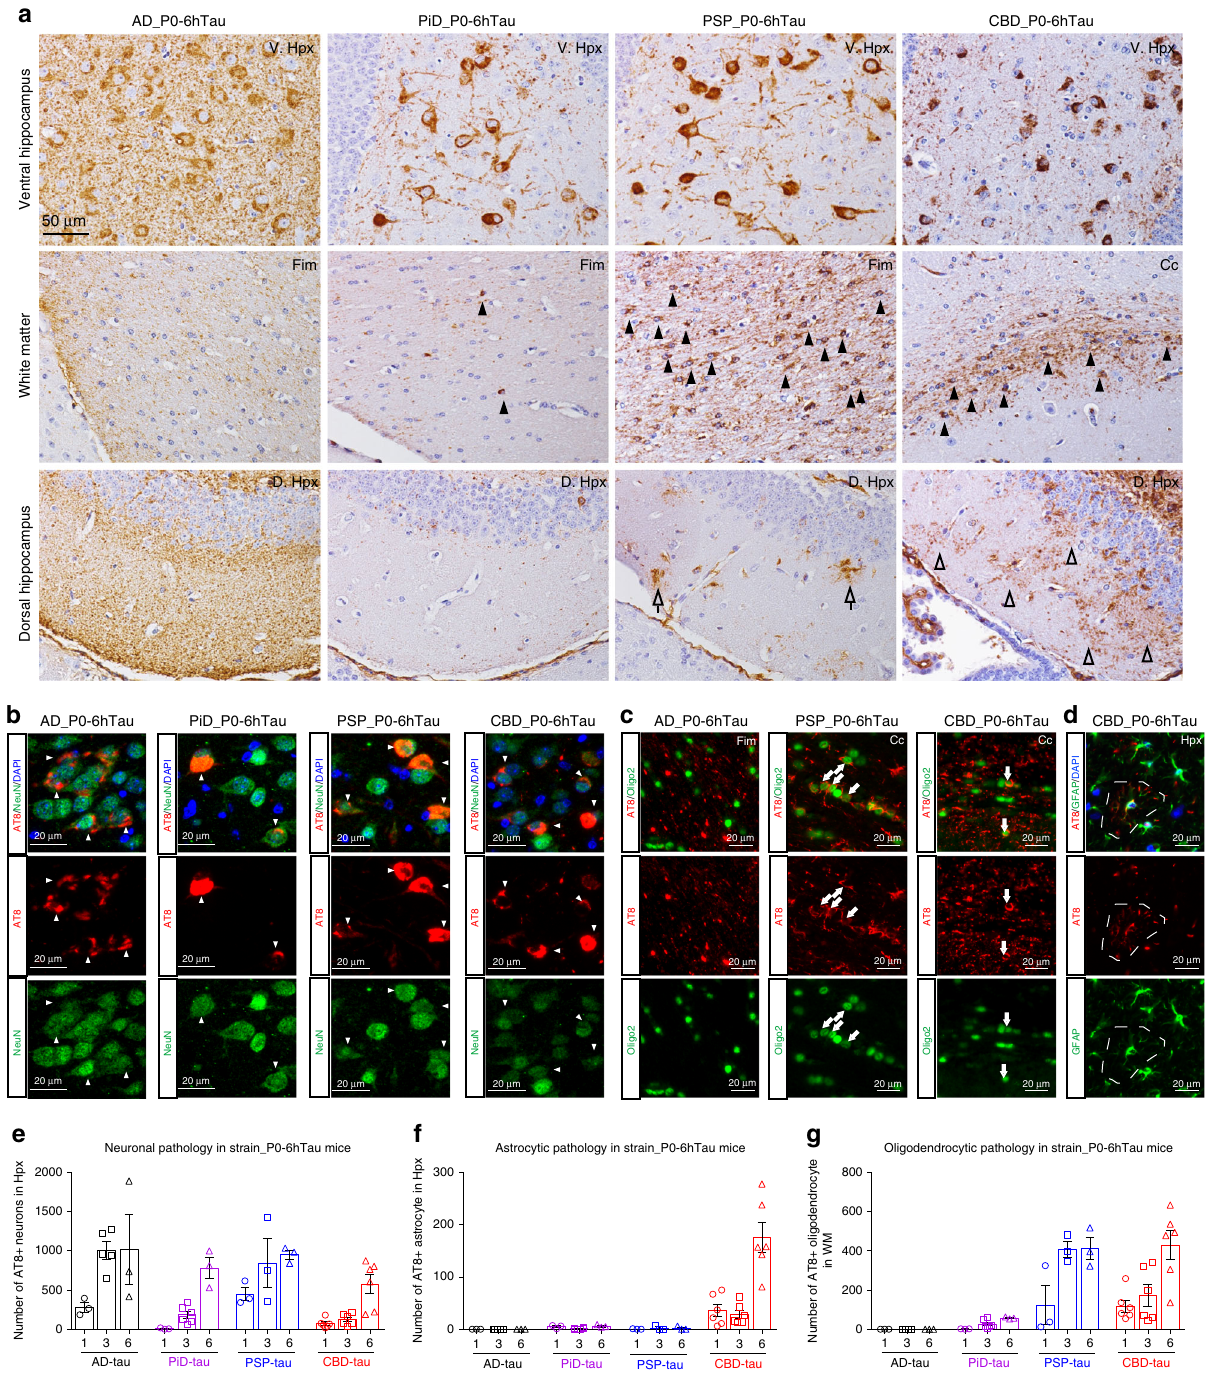
Fig. 6 Distinct cell-type-speci fi c tau strains were recapitulated in new model. a Representative IHC staining with AT8 on brain sections from 6hTau mice unilaterally inoculated with distinct human tau strains (P0) at 3 m.p.i. The upper panels showing neuronal tau pathologies in the hippocampus. Middle panels showing white matter with oligodendrocyte tau pathologies induced by PSP_P0 and CBD_P0. The lower panels show tufted-astrocyte-like tau pathologies induced by PSP_P0 and astrocytic plaque-like tau pathologies induced by CBD_P0 in the hippocampus. Oligodendrocytic and astrocytic tau pathologies are indicated by solid and open arrowheads, respectively. Representative double immuno fl uorescence staining with anti-hyperphosphorylated tau MAb AT8 and b neuronal marker NeuN; c oligodendrocytic marker, Oligo2 and d astrocytic marker GFAP on the pathologies induced, respectively, by strain_P0 in 6hTau mice. Neuronal, oligodendrocytic and astrocytic tau pathologies are indicated by white arrowheads, white arrows and dashed circle, respectively. Quanti fi cation of e neuronal; f astrocytic and g oligodendrocytic tau pathologies in the 6hTau mice inoculated with distinct P0 human tau strains at 1, 3, and 6 m.p.i. Both ipsilateral and contralateral sides were quanti fi ed together for each mouse. Data are presented as mean ± s.e.m.. n = 3 – 6 for each group, and each dot represents a mouse subjected to quantitation. WM white matter, Fim fi mbria, Cc corpus callosum, Hpx, hippocampus. Source data is available as a Source Data fi